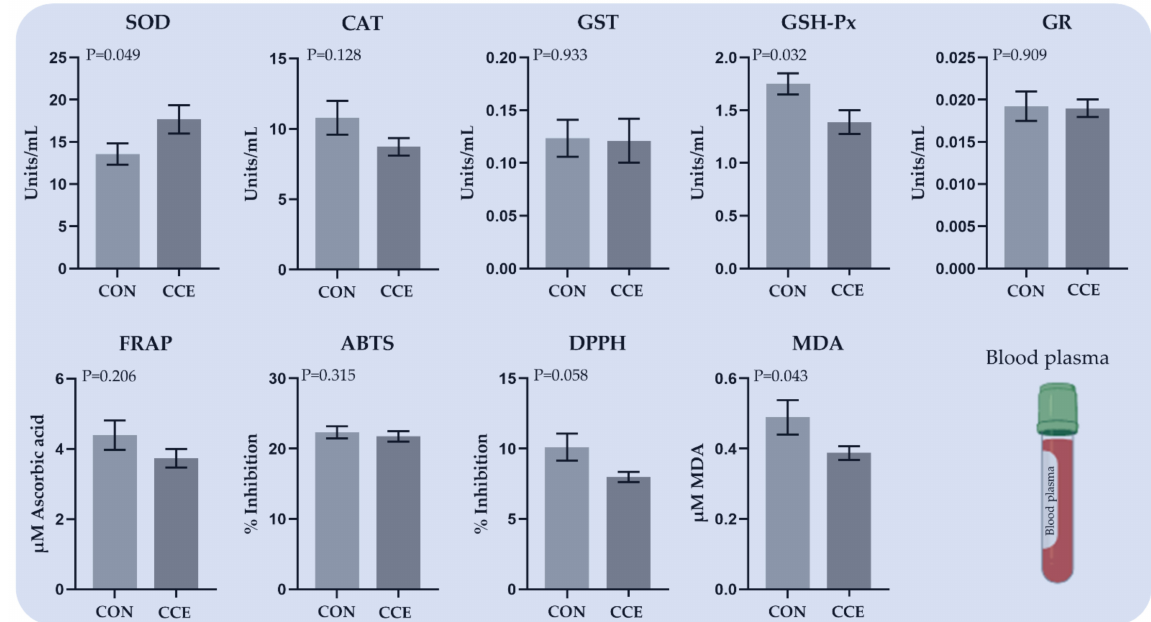
Figure 5. The mean ± SEM of total antioxidant capacity, oxidative stress indicators, and enzyme activities (Units/mL), in the blood plasma of broilers fed the two experimental diets (Control; CON, and carotenoid extract from Citrus reticulata included in soluble starch; CCE) at 42 days. SOD: Superoxide Dismutase, CAT: Catalase, GST: Glutathione Transferase, GSH-Px: Glutathione Peroxidase, GR: Glutathione Reductase, FRAP: Ferric Reducing Ability of Plasma , ABTS: 2,2 (cid:48) -azinobis-(3-ethylbenzothiazoline- 6-sulfonate), DPPH: 2,2 (cid:48) -diphenyl-1-picrylhydrazyl radical, and MDA: Malondialdehyde